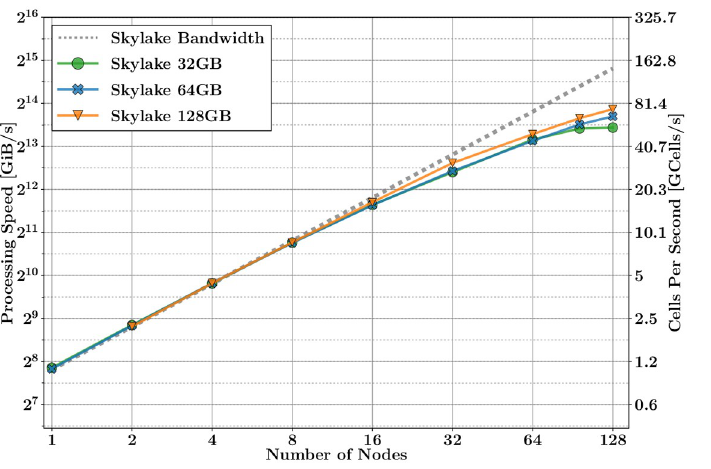
Fig 6. UGRFDTD performance on multiple nodes of MareNostrum